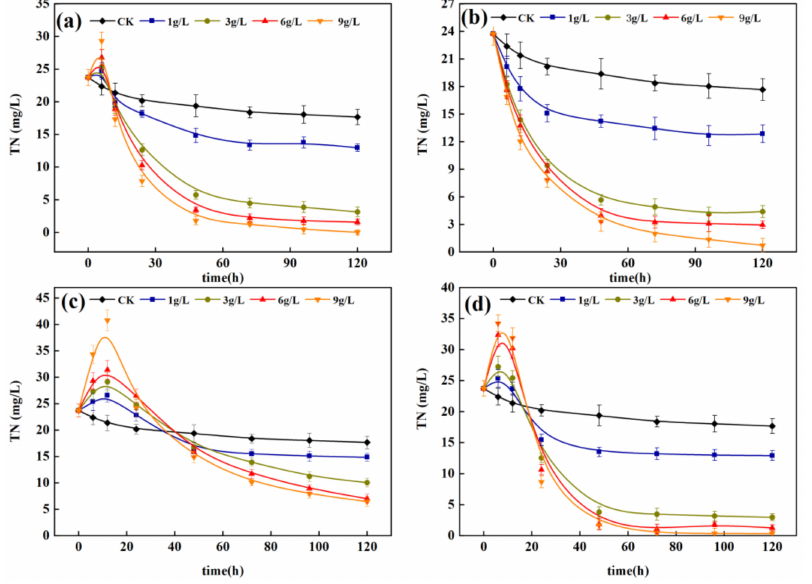
Figure 5. TN removal effect in water body under different carbon source dosage. ( a ) PS; ( b ) SD; ( c ) PT; ( d ) MT.